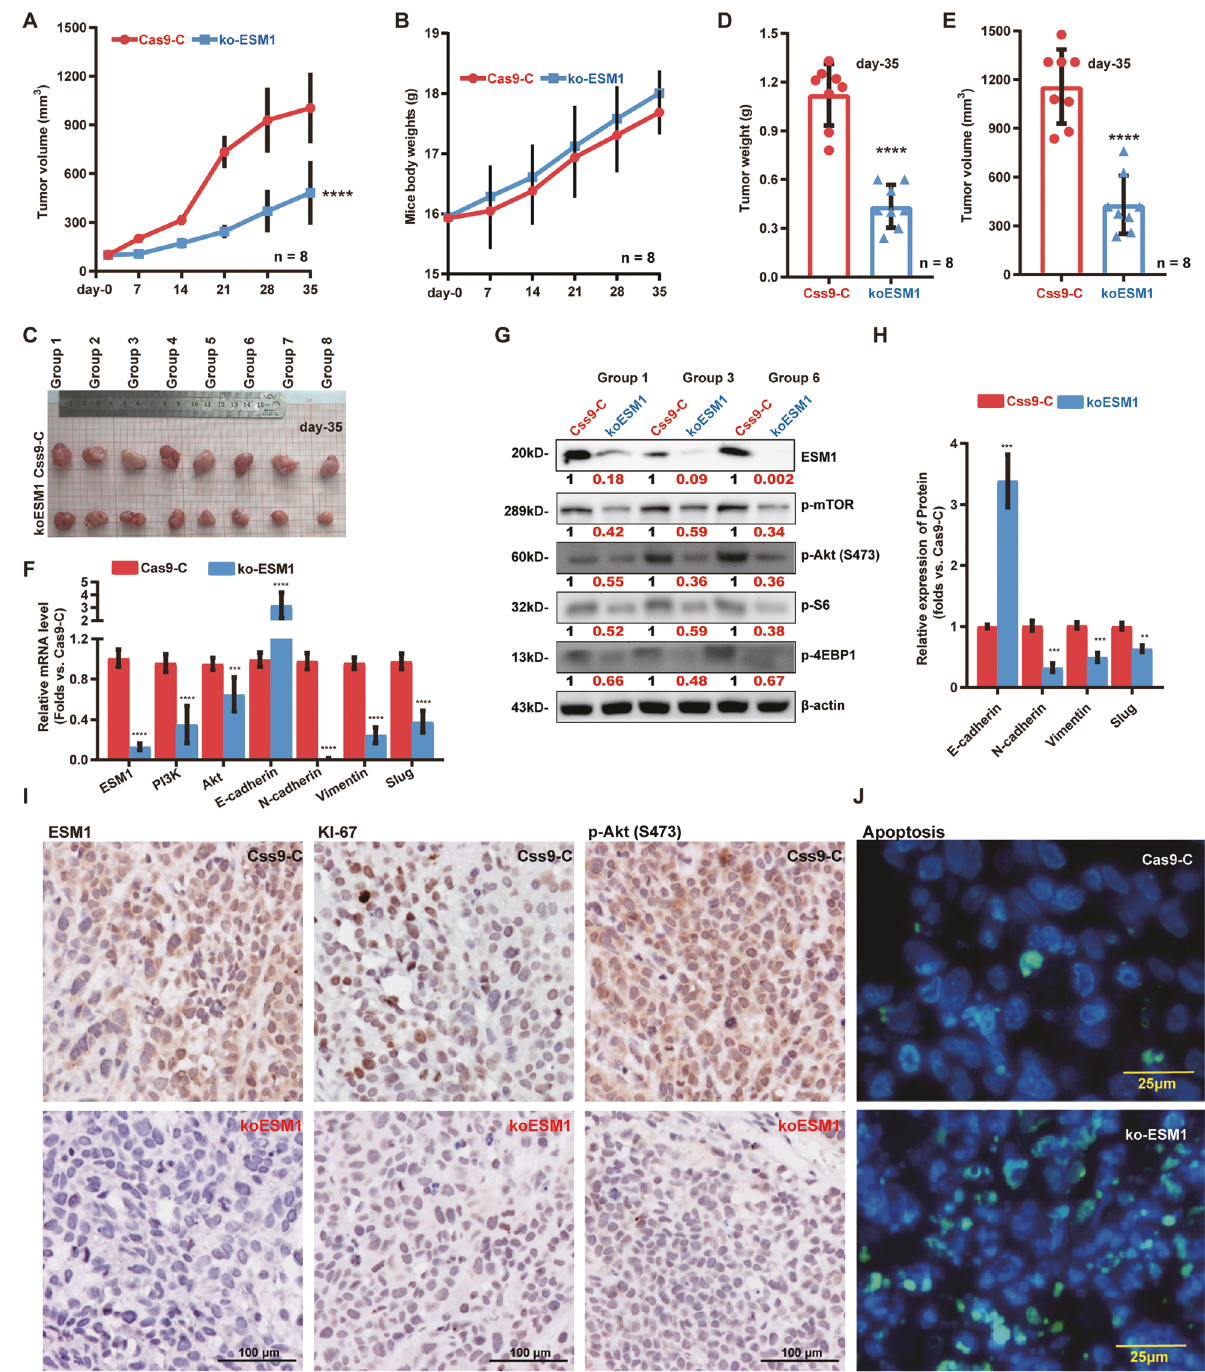
Fig. 6 ESM1 knockout inhibits cervical cancer xenograft growth in mice. SiHa xenograft-bearing female BALB/c nude mice were established by subcutaneous injection of SiHa cells with the lentiviral CRISPR/Cas9-ESM1-KO construct ( “ koESM1 ” ) or the CRISPR/Cas9 control empty vector ( “ Cas9-C ” ). Tumor volumes ( A ) and mice body weights ( B ) were recorded every seven days. After 35 days, all tumors were separated ( C ), tumor weights ( D ) and volumes ( E ) were recorded. qRT-PCR ( F ) was used to test the mRNA expression level of ESM1 , PI3K , Akt , E-cadherin , N-cadherin , Slug , and Vimentin . ESM1 and phosphorylation levels of mTOR, Akt, S6, and 4EBP1 were detected by Western blotting ( G) . EMT proteins were tsted and results were quanti fi ed ( H ). Immunohistochemistry (IHC) staining was used to test the expression of ESM1, Ki67, and p-Akt (Ser-473) in xenograft slides ( I ). The tissue slide TUNEL staining assays were conducted to test cell apoptosis in koESM1 xenografts and Cas9-C xenografts ( J ). The data were presented as mean ± standard deviation (SD). ** P < 0.01, *** P < 0.001, **** P < 0.0001 vs. “ Cas9-C ” xenografts. Scale bar = 25/100 μ m.